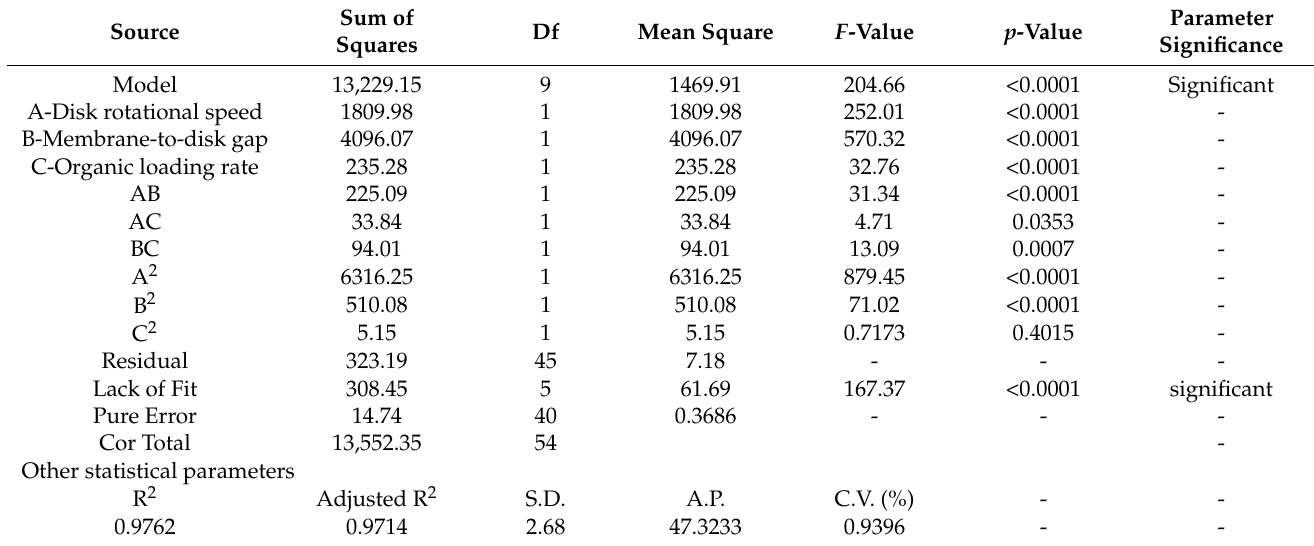
Table 4. ANOVA results of the coefficient of quadratic model for